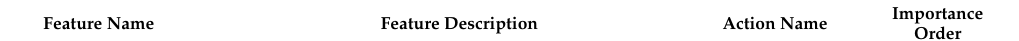
Table A1. The features of the feature-based